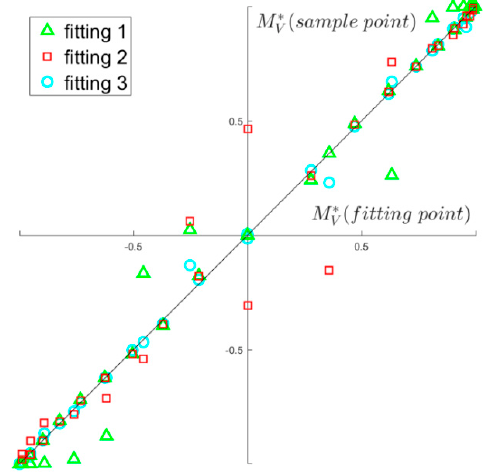
Figure 25. The case of a damaged hull due to collision.